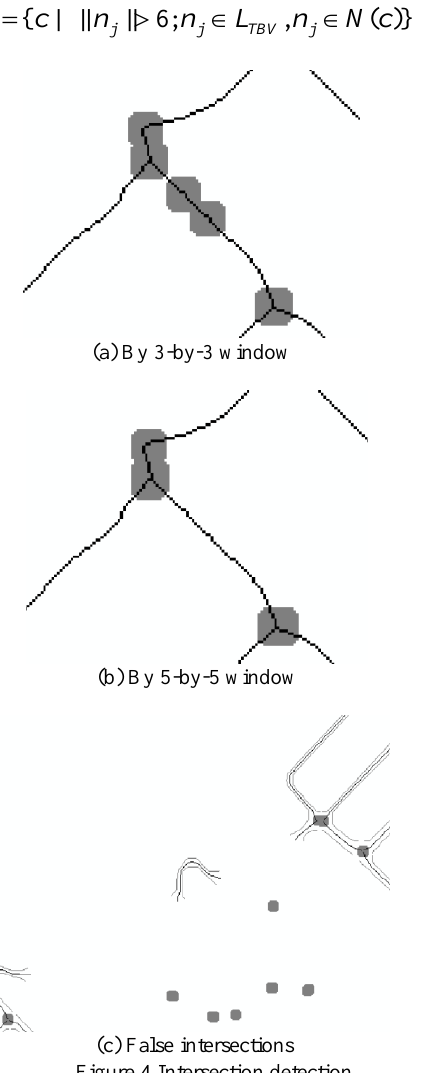
Figure 4 Intersection